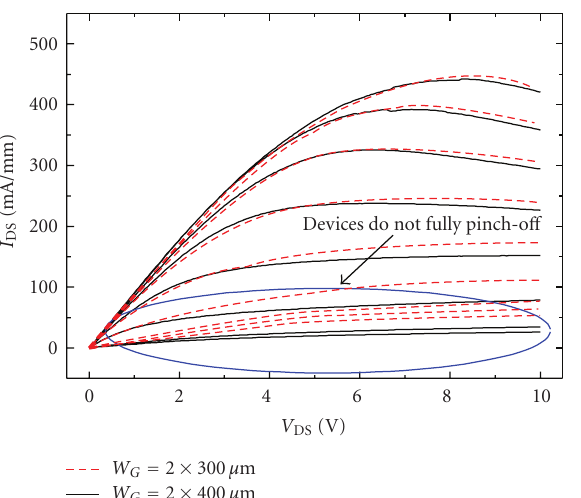
Figure 10: I DS against V DS characteristics of fabricated two-finger 3 μ m gate length AlN/GaN MOS-HEMT mesa devices with unopti- mised etching time (Al etch for 10secs). The devices had no mesa sidewall passivation and were biased from V GS = +3 V to − 4 V with a step size of 1 V.